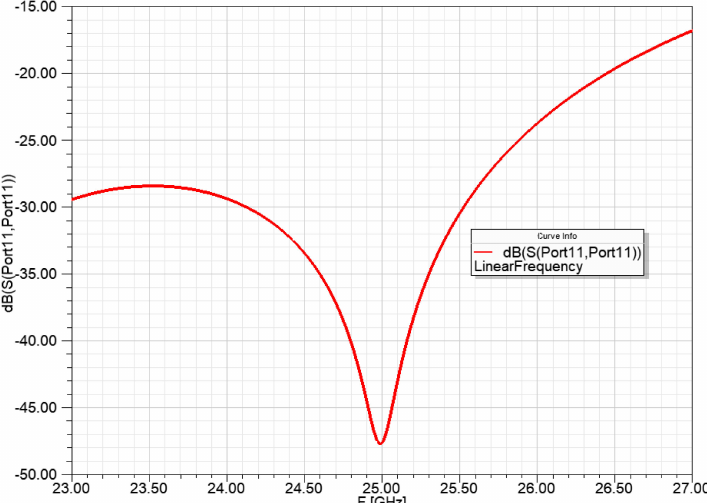
Figure 14. Input reflection of the power division network from 1 to 4:2:4 power ratio, with ideal transmission